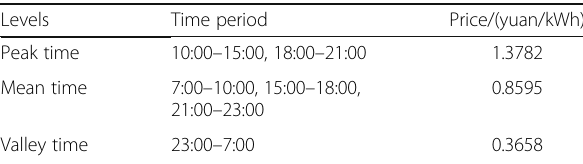
Table 2 Time-of-use price